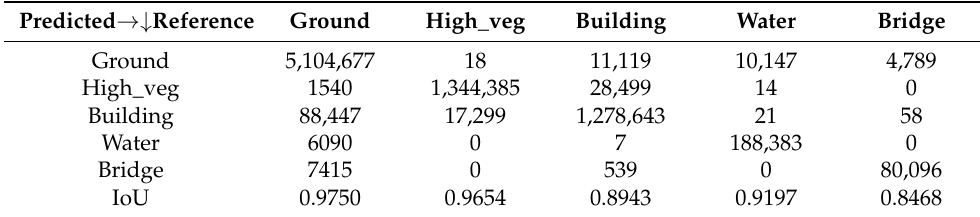
Table 6. The confusion matrix of our method on the DFC 3D test set.